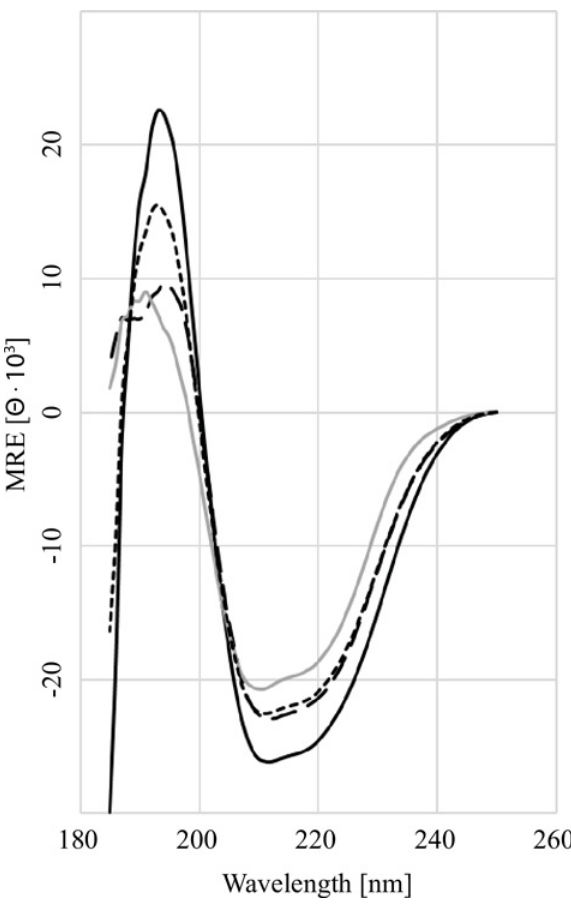
Fig 7. Far UV CD-Spectroscopy of GARP and TGF β . The far-UV spectra (25°C, 260 – 185 nm) for the following samples are as indicated: GARP TS alone (black solid line), latent TGF β alone (grey solid line), summed spectrum of GARP TS and latent TGF β (short-dashed line), measured spectra of the GARP TS and latent TGF β complex (long dashed line). The decrease in the mean relative ellipticity below 200 nm between the calculated and measured spectra of the complex formation of GARP TS and TGF β indicates a conformational change in